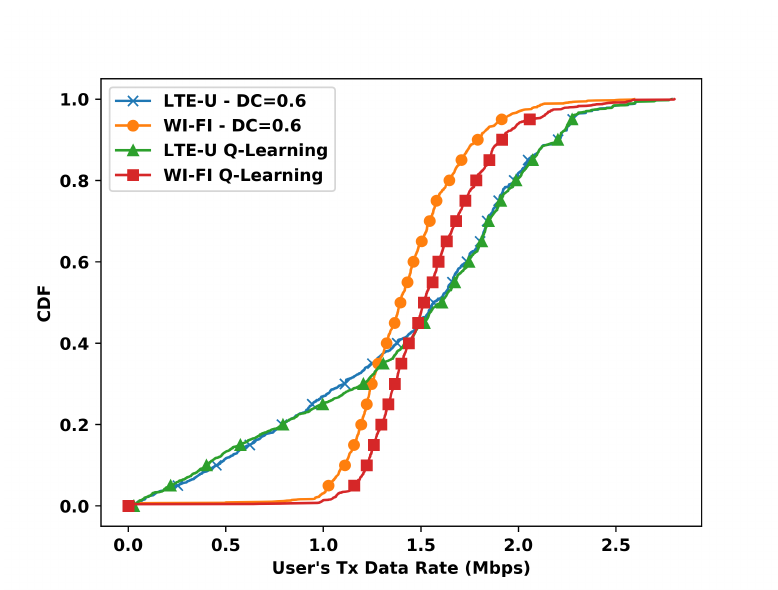
Figure 9. Cumulative density function (CDF) of transmitted data rate per user vs Q-Learning for DC =